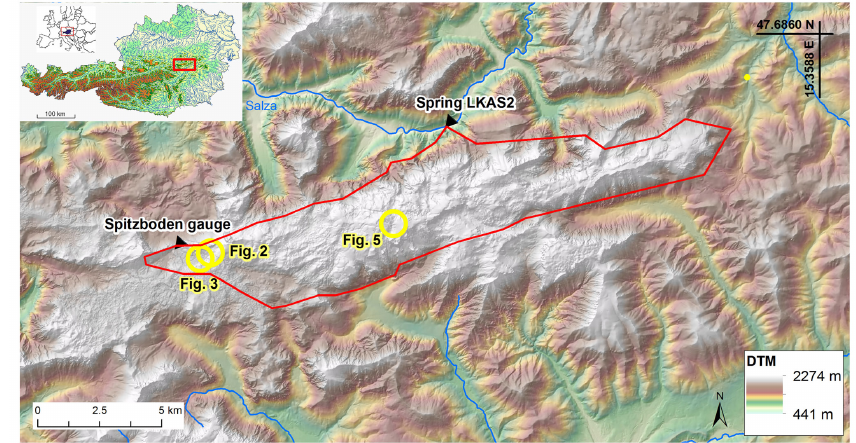
Figure 1. Area subject to mapping (red line) in the catchment of the Hochschwab spring (LKAS2). Yellow circles indicate the locations of Figs. 2, 3 and